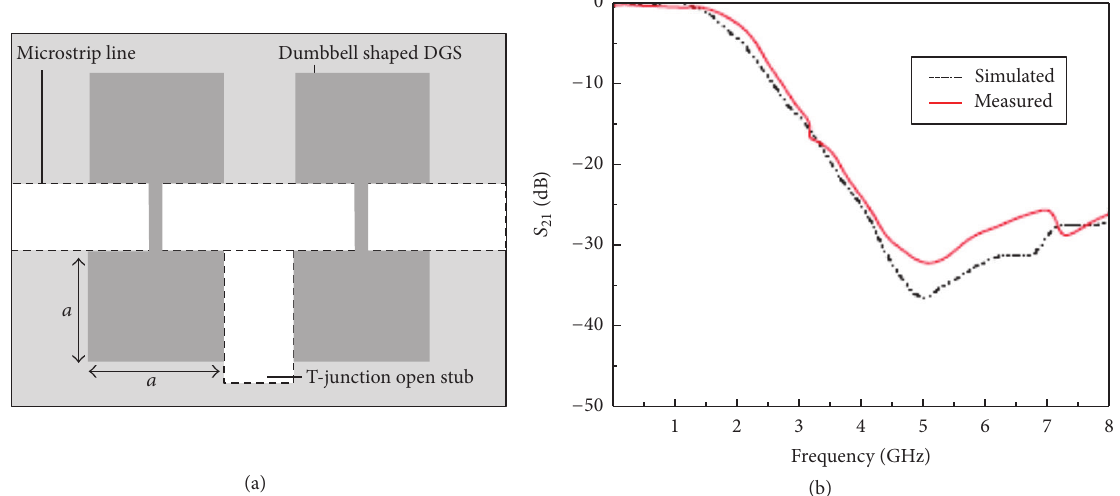
Figure 11: Low pass filter with cascaded dumbbell shaped DGS integrated with microstrip transmission line along with T-junction stub: (a) schematic diagram; (b) simulated 𝑆 -parameters [12].